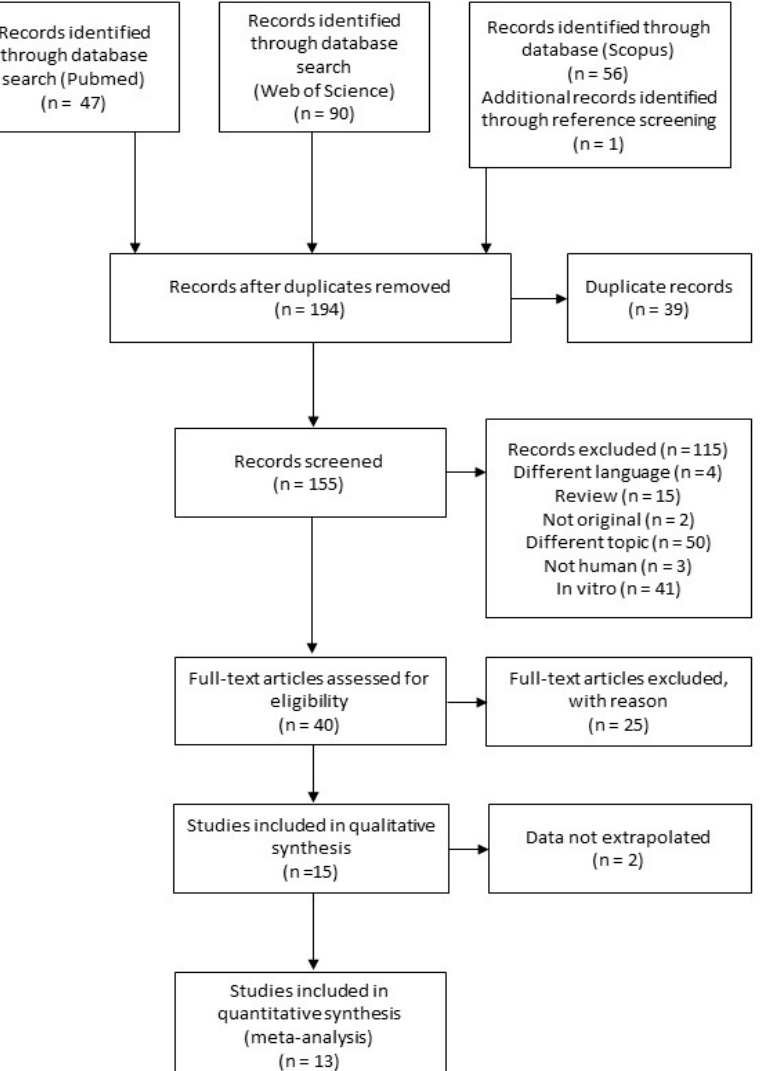
Figure 1. Flow diagram of studies selection process.